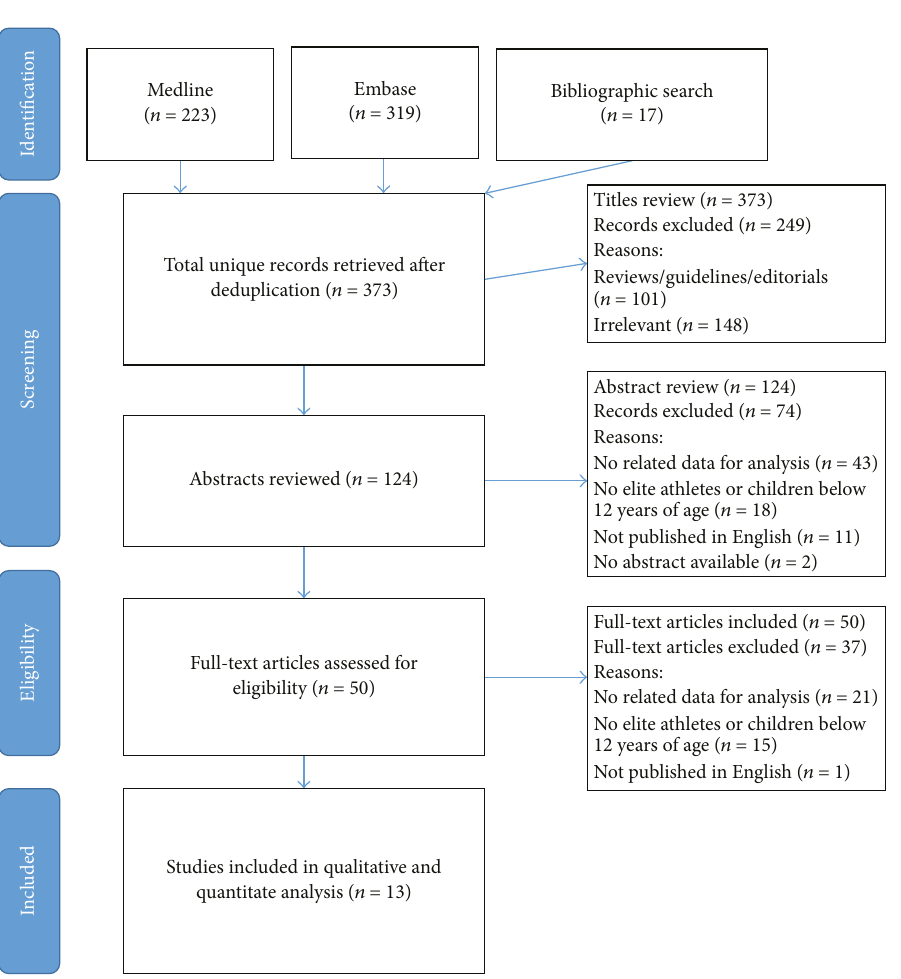
Figure 1: Data extraction and